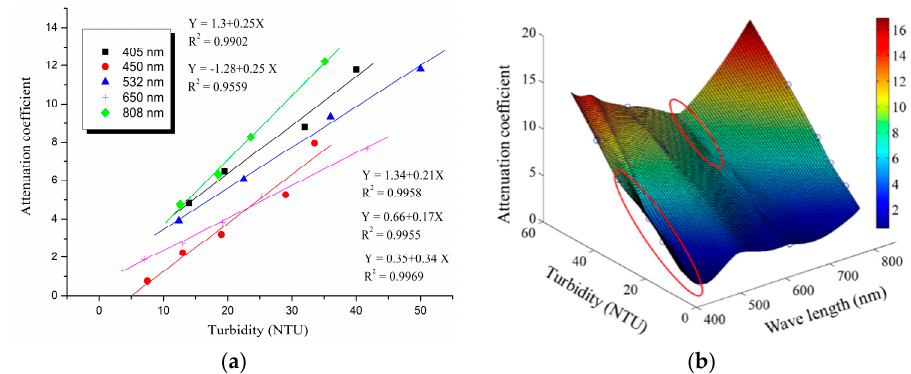
Figure 4. Attenuation coefficient—turbidity curve in silt dissolution medium: (a) Two dimension; (b) Three dimension